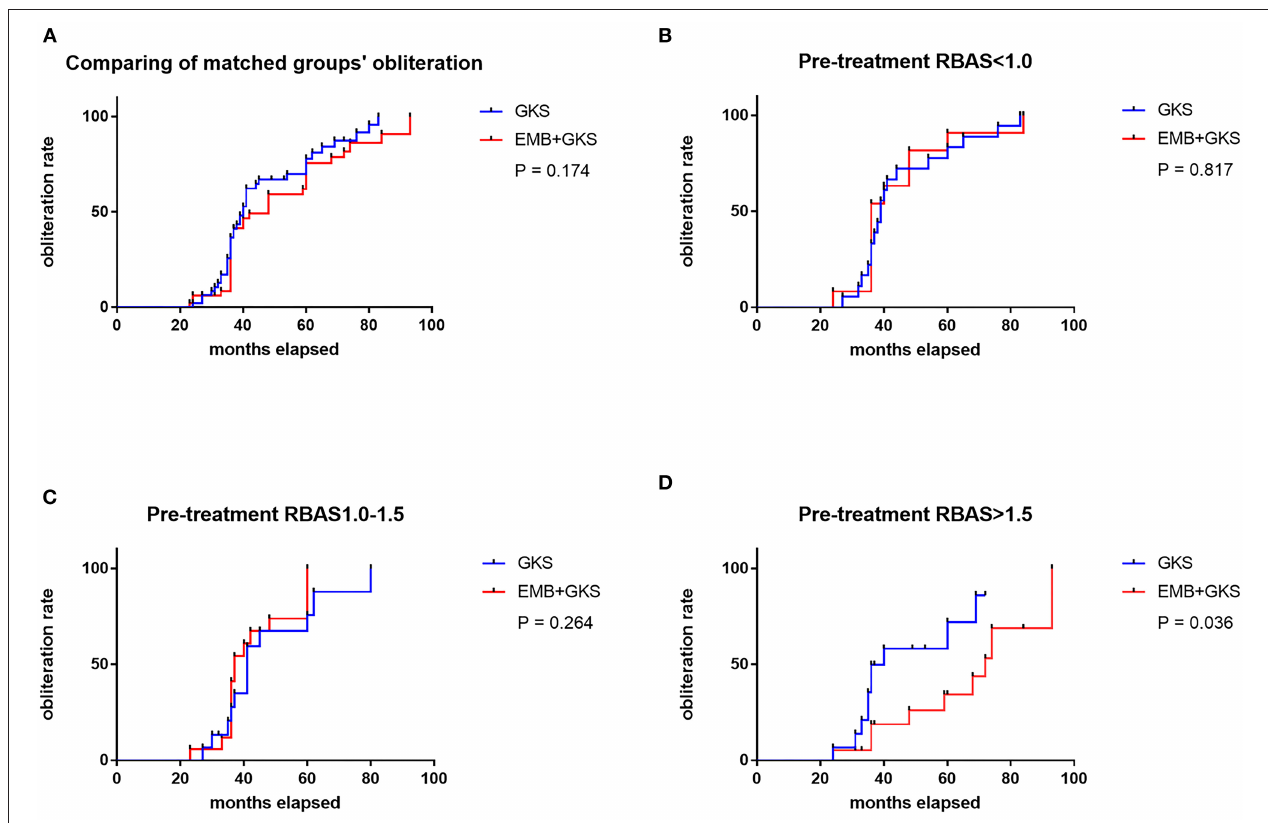
FIGURE 3 | (A) Comparison of obliteration rate between groups by Kaplan–Meier analysis. No significant difference was found between the two treatment modalities (75.0 vs. 83.3%, p = 0.174). (B–D) Comparison of obliteration rate between sub-groups; the obliteration rate of GKS group is statistically higher than the combined treatment group when pre-treatment RBAS > 1.5 (47.4 vs. 66.7%, p =